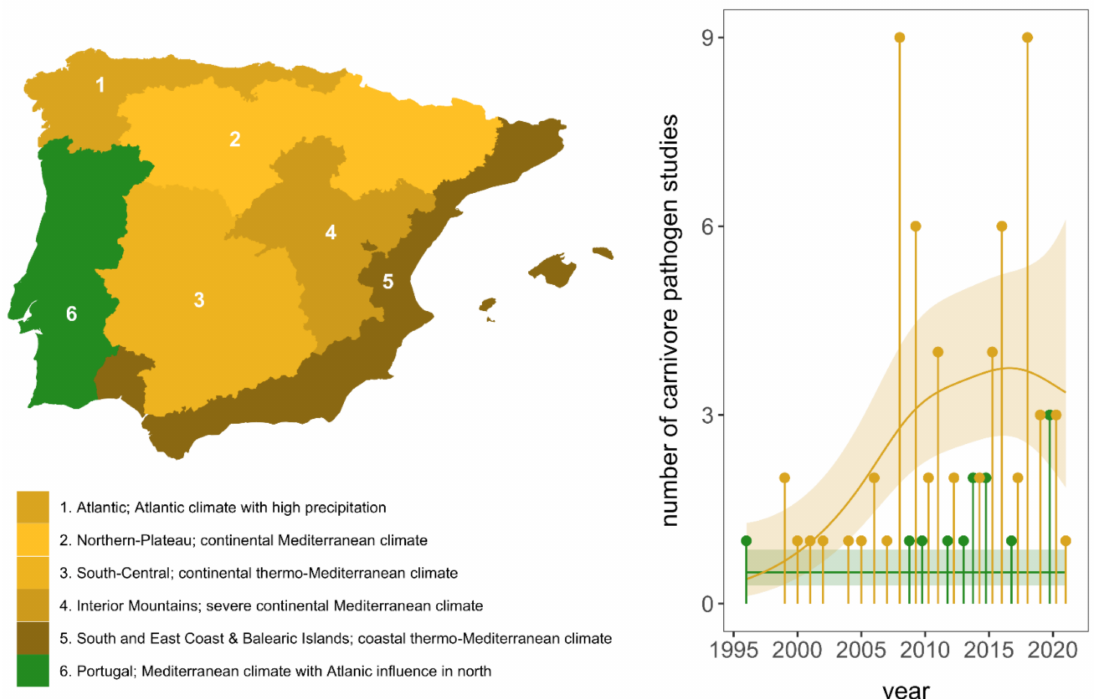
Figure 1. ( Left ): Bioregions of Iberia and their associated climatic conditions. ( Right ): Number of studies of microparasites of carnivores in the Iberian Peninsula per year and country (yellow = Spain, green = Portugal). Points are jittered to reduce overlap and are overlaid with the fitted mean and 95% confidence interval band from our GAM of study effort over time. See Table 1 for details about carnivore species presence on the different